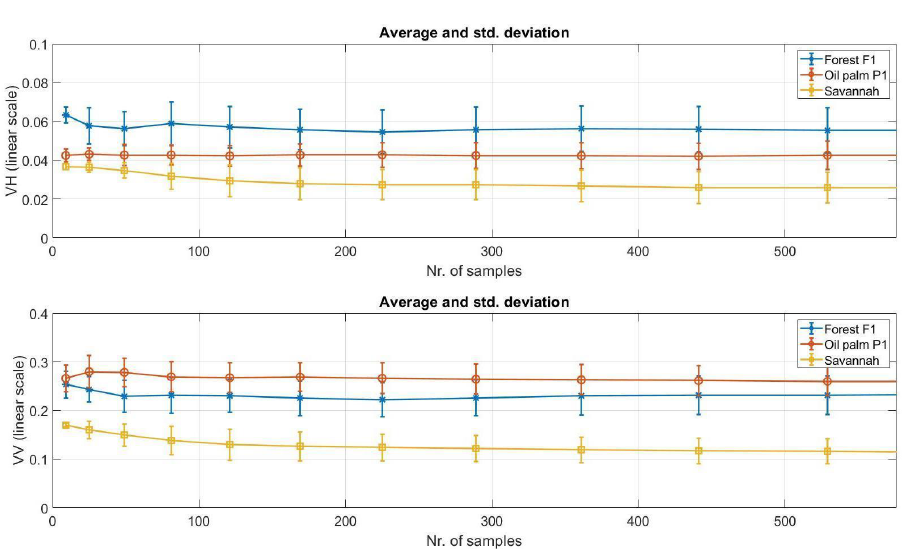
Figure 15. Variation of mean and standard deviation of ( top ) VH and ( bottom ) VV backscatter as a function of the number of samples for polygons F1, P1 and S in the 2021 acquisition for the wet